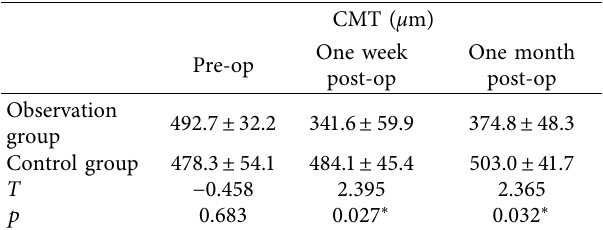
Table 3: Comparison of CMTat different time points between the observation group and control